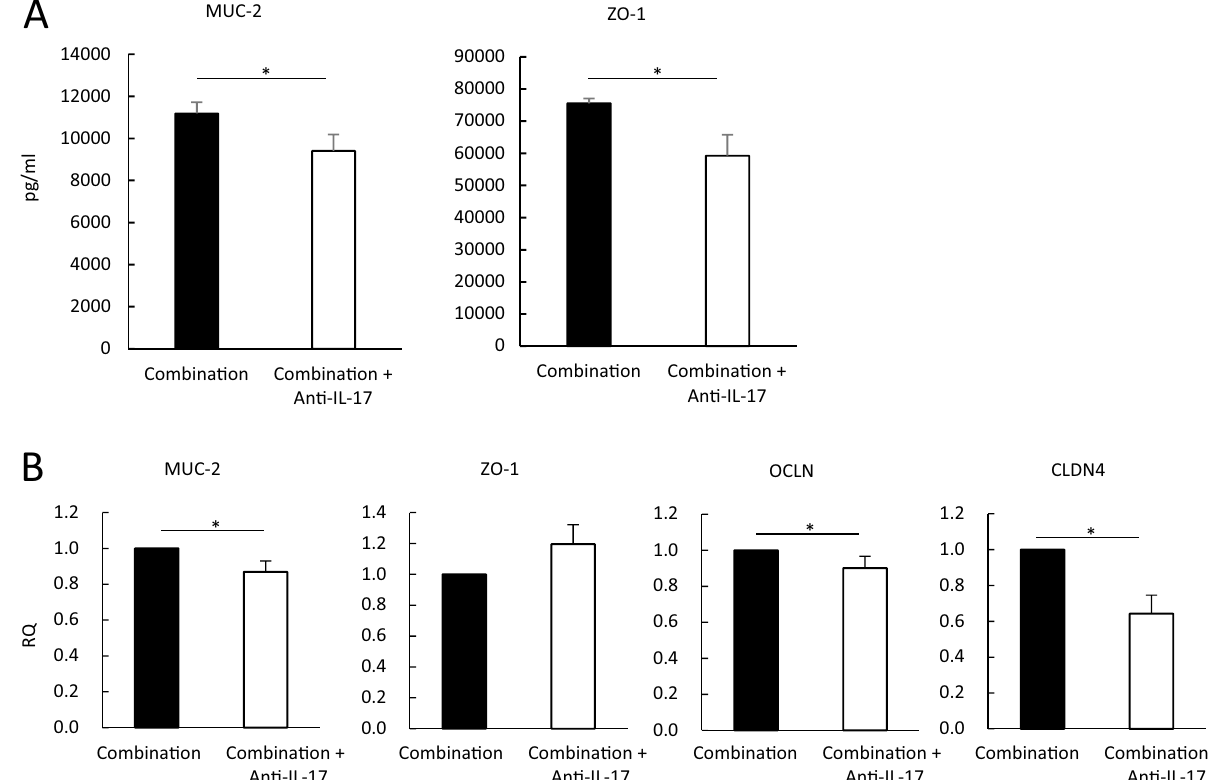
Figure 7. Th17 cells activated with C. butyricum strengthen colon epithelial cells under CDI. ( A ) The mucin-2 (MUC-2) and zonula occludens (ZO-1) protein concentrations in each animal group were detected. 1: combination (CBM 588 + fidaxomicin) group (Combination), 2: combination group + anti- IL-17A antibody. ( B ) The relative RNA expression of genes encoding MUC-2, claudin (CLDN4), ZO-1, and occludin (OCLN) in mice colon tissue, detected by qPCR. All values are mean ± SD (n =